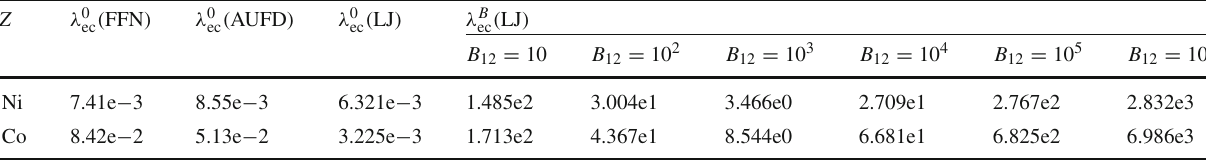
Table 2 Comparisons of the no SMFs rates of FFN [2] ( λ 0 ec ( FFN ) ), AUFD [6] ( λ 0 ec ( AUFD ) ), and our rates ( λ 0 ec ( LJ )) , with those of ours λ B ec ( LJ ) in SMFs for ρ 7 = 4 . 32 , Y e = 0 . 47 , T 9 = 3 . 26, respectively